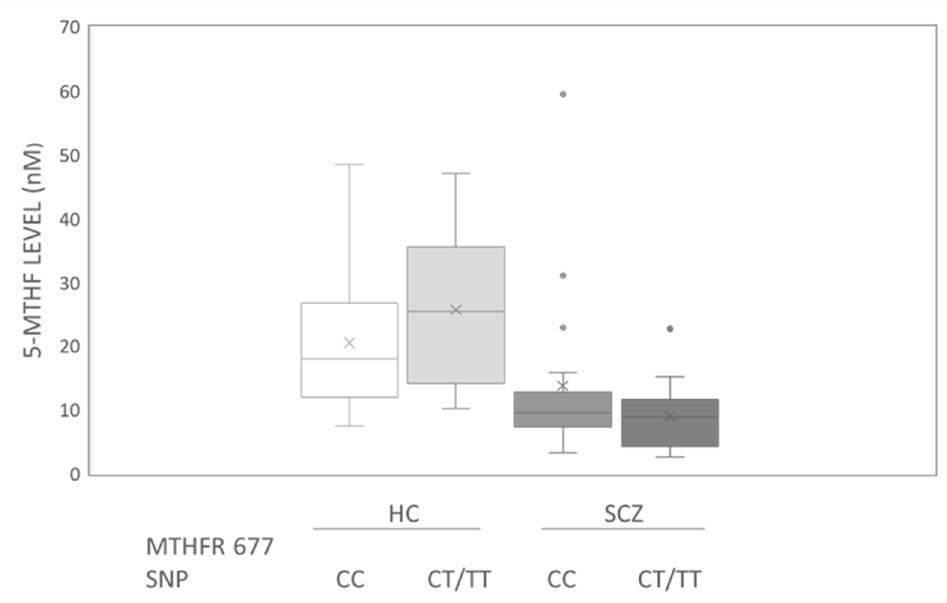
Figure 2. Median levels of 5-MTHF concentration in schizophrenia patients (SCZ; n = 34) vs. healthy controls (HC; n = 42), subgrouped by variants of MTHF677 polymorphisms. The outliers in schizophrenia are indicated as dots either in CC or CT/TT carriers. × markers indicate mean value of each group. Table 4. Sex differences in 5-MTHF levels in schizophrenic patients with different patterns of MTHFR C677T and PON1 variants.